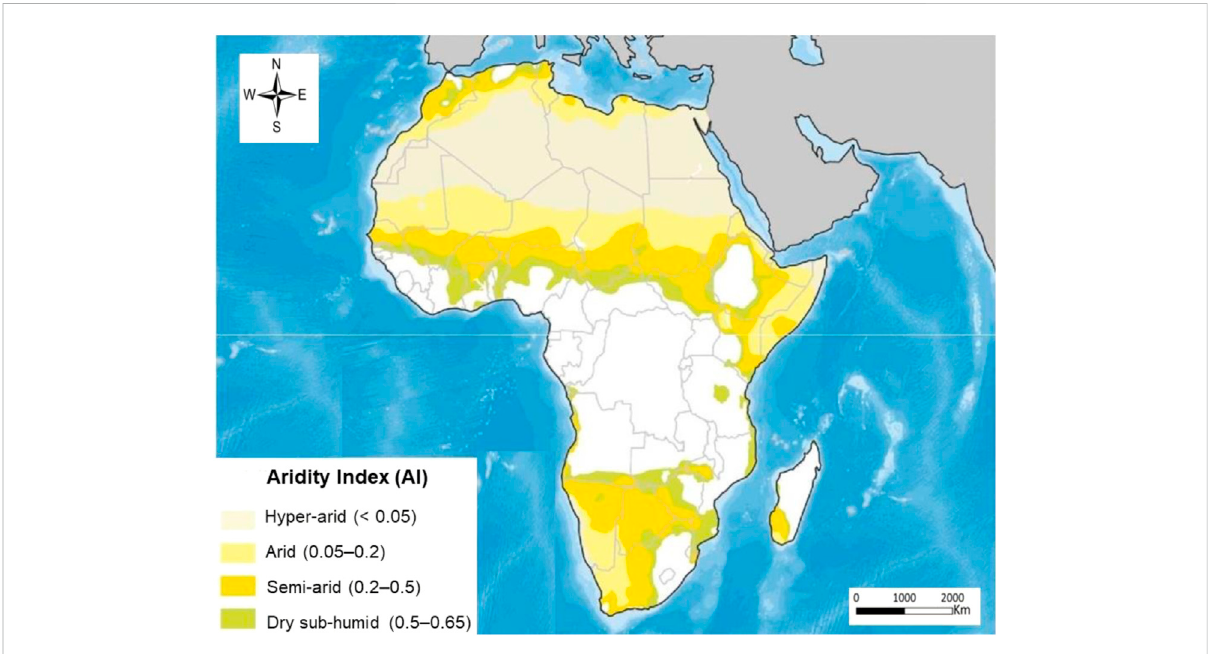
FIGURE 1 Distribution of Africa ’ s drylands based on aridity index (AI). The AI was calculated using the annual precipitation (P) and potential evapotranspiration (PET) based on the 1970 – 2000 mean global-AI and global_ET0 datasets (Trabucco and Zomer, 2018). The hyper-arid zones are not considered in this